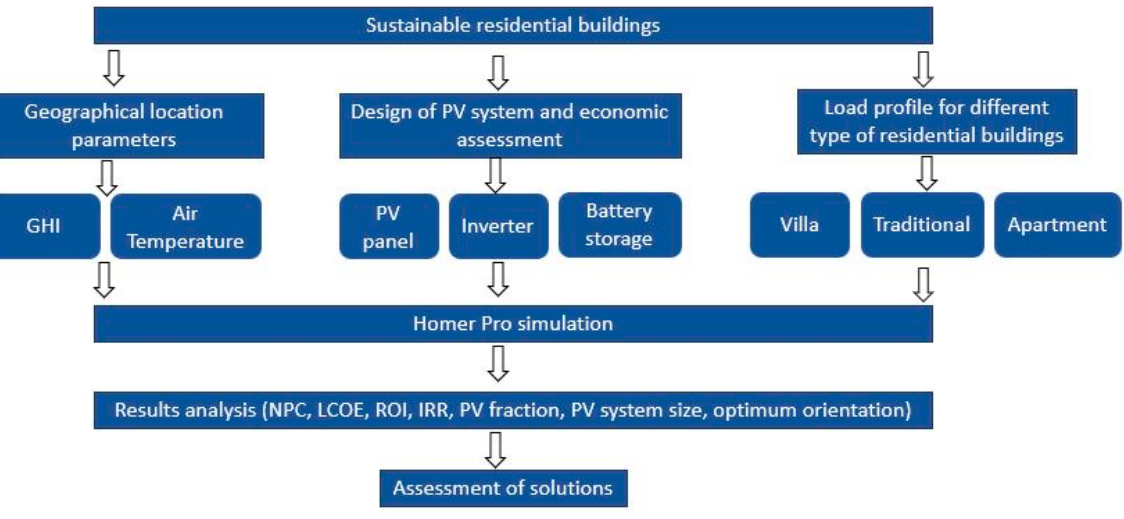
Figure 1. Methodology flow chart.